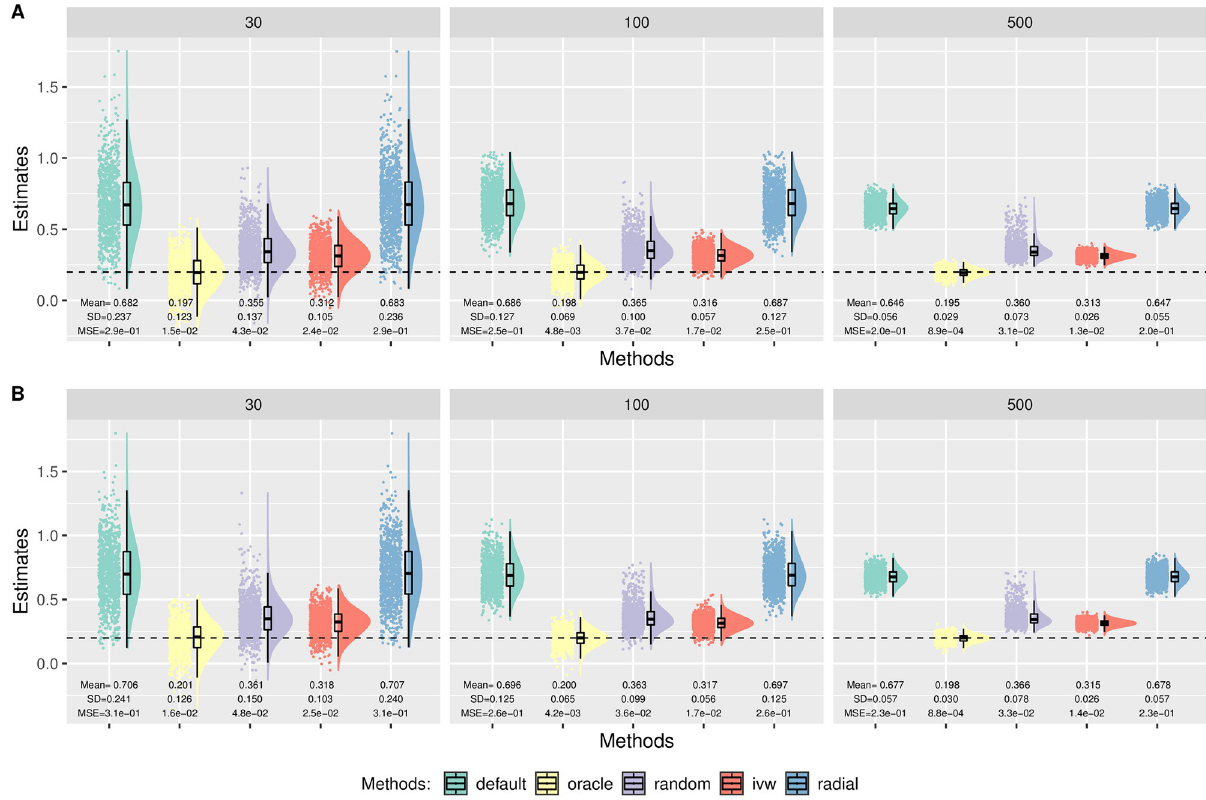
Fig 4. Simulation (b) results with directional pleiotropy. Empirical distributions of the estimates of the causal effect θ by the methods with 30% invalid IVs and θ = 0.2. Each column corresponds to m = 30, 100 or 500 IVs. A: n = 50 000. B: n = 100 000.